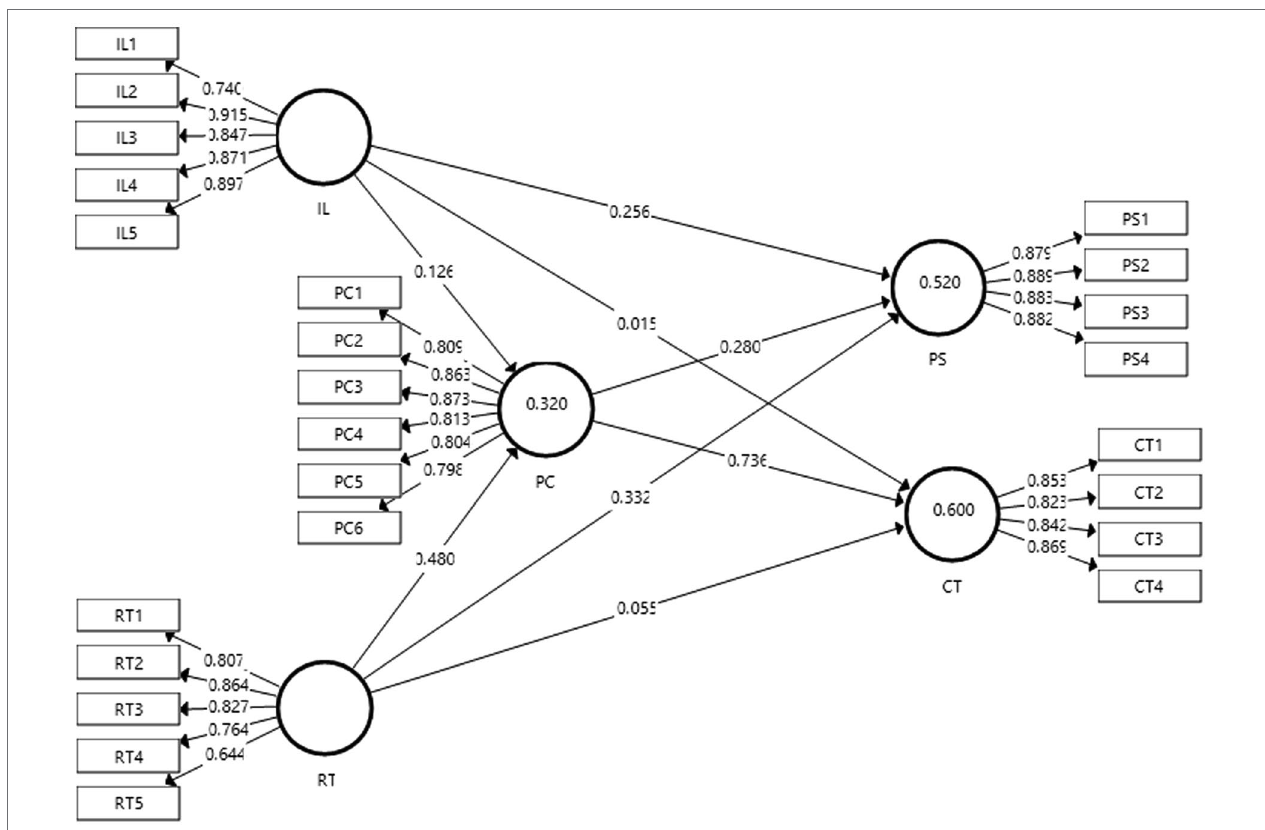
FIGURE 2 | Output of measurement model. IL, inquiry learning; RT, reflective thinking; PS, problem-solving skills; CT, critical thinking skills; and PC, Peer